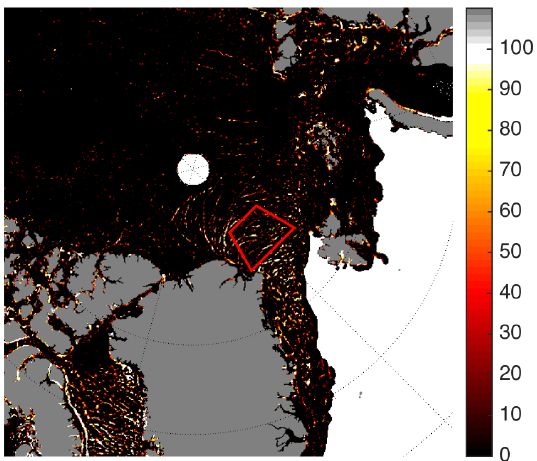
Figure 2. Area of interest is included within the red rectangle. The background map shows AMSR-E lead fraction in percent (the num- bers on the colour scale to the right), obtained on the 8 March 2009, and is used here only to demonstrate a sample from the product.